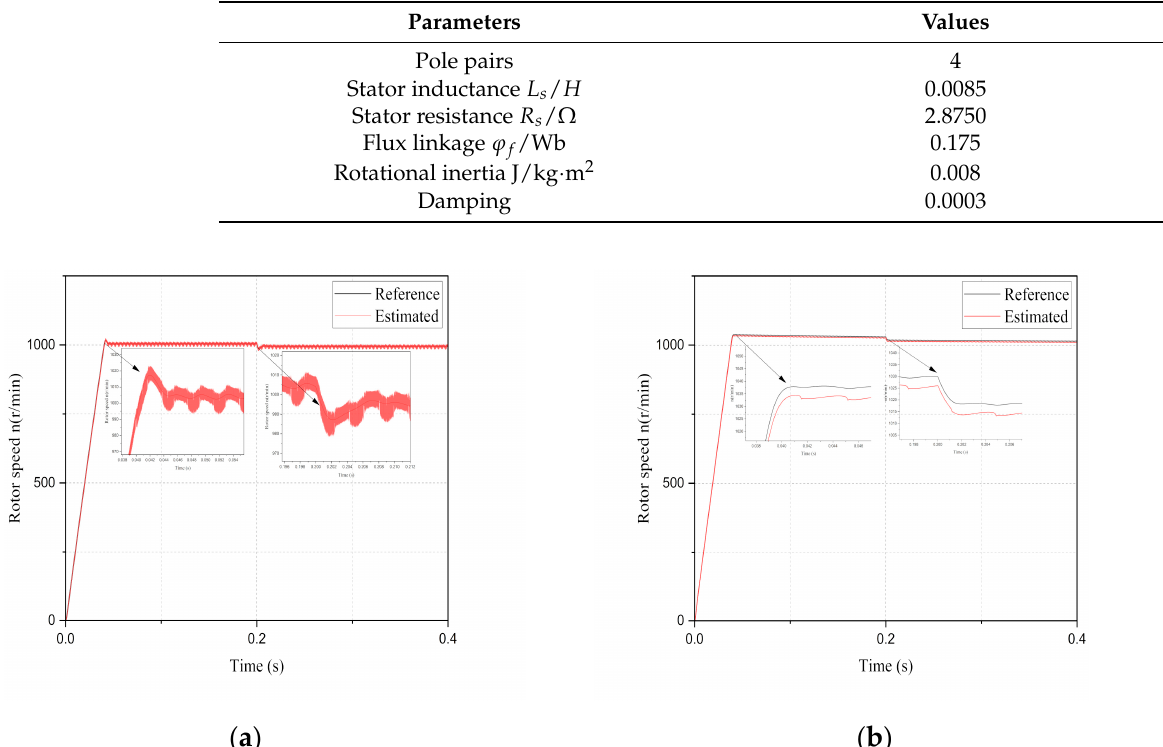
Figure 4. Simulation results of rotor speed. ( a ) Traditional SMO, ( b ) new SMO.